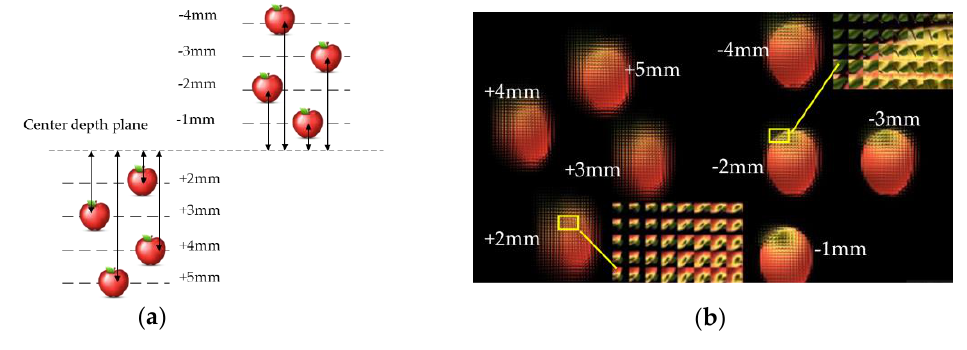
Figure 4. ( a ) Eight apples in 3d Max software; ( b ) generated EIA.